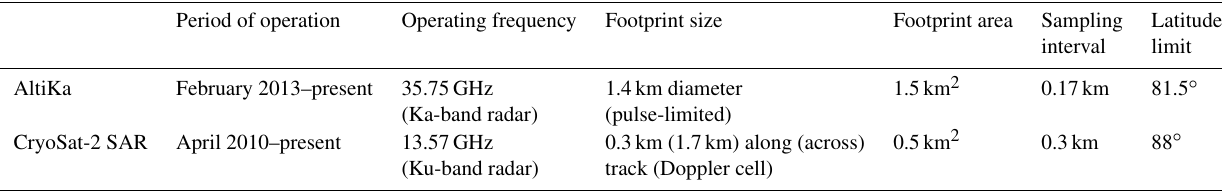
Table 1. AltiKa and CS-2 (SAR mode) operation